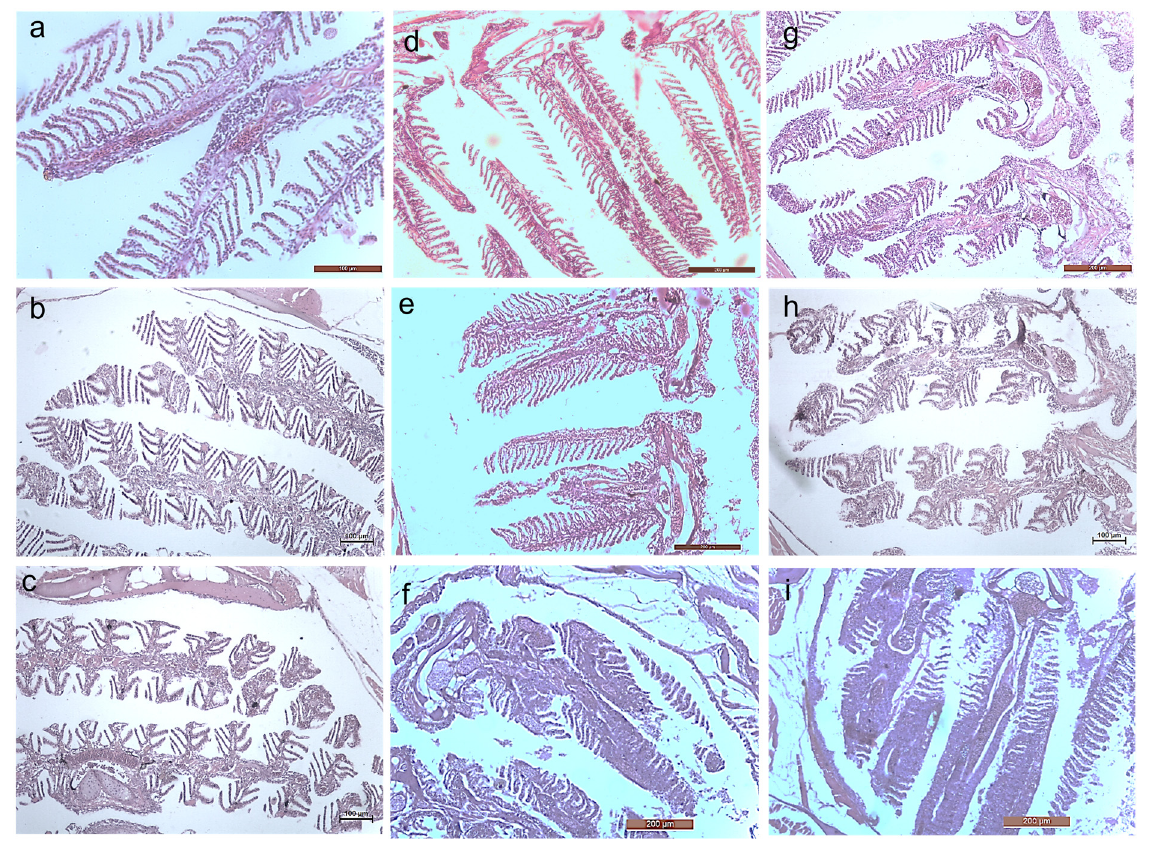
Figure 15. Histology images of gills of Zebrafish— Danio rerio (10X Magnification) ( a ) 10th day control, ( b ) exposed to 10 µg at 10th day, ( c ) exposed to 20 µg at 10th day; ( d ) 20th day control, ( e ) exposed to 10 µg at 20th day, ( f ) exposed to 20 µg at 20th day; ( g ) 30th day control, ( h ) exposed to 10 µg at 30th day, ( i ) exposed to 20 µg at 30th day.